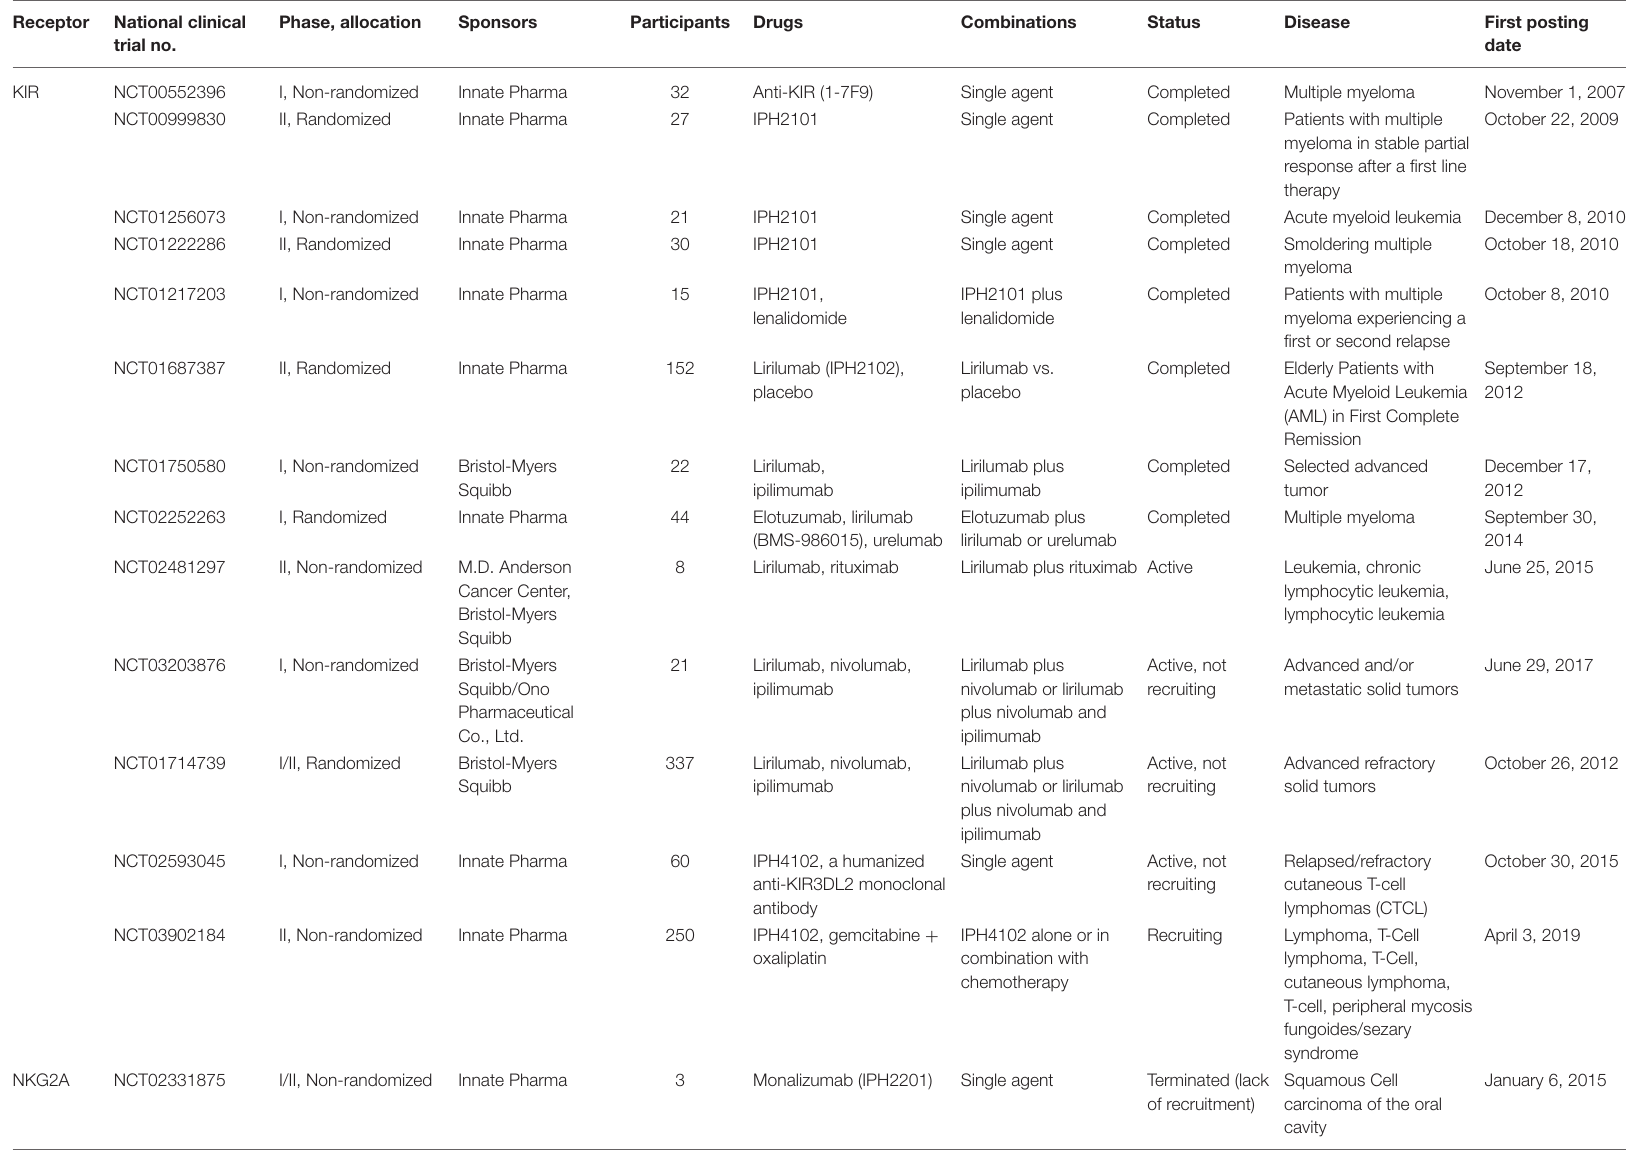
TABLE 1 | Clinical trials evaluating the safety, tolerability and efficacy of NK cell-based immune checkpoint inhibitors or potential immune checkpoint inhibitors for NK cell-based immunotherapy. Receptor National clinical Phase, allocation Sponsors Participants Drugs Combinations Status Disease First posting trial no.